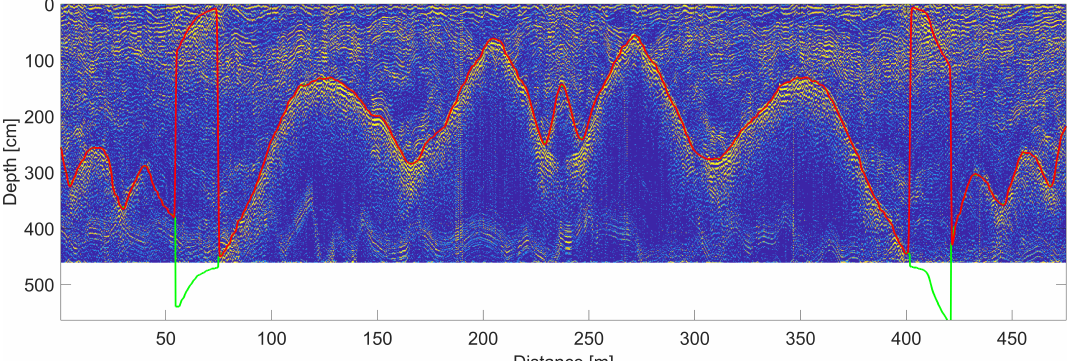
Figure 7. B-scan radar image of one pass back and forth across the transect. Red line indicates the snow–ground interface and green line indicates the snow–ground interface detected in the second signal period, with range ambiguity (i.e., deeper than ≈ 460cm for (cid:101) r =